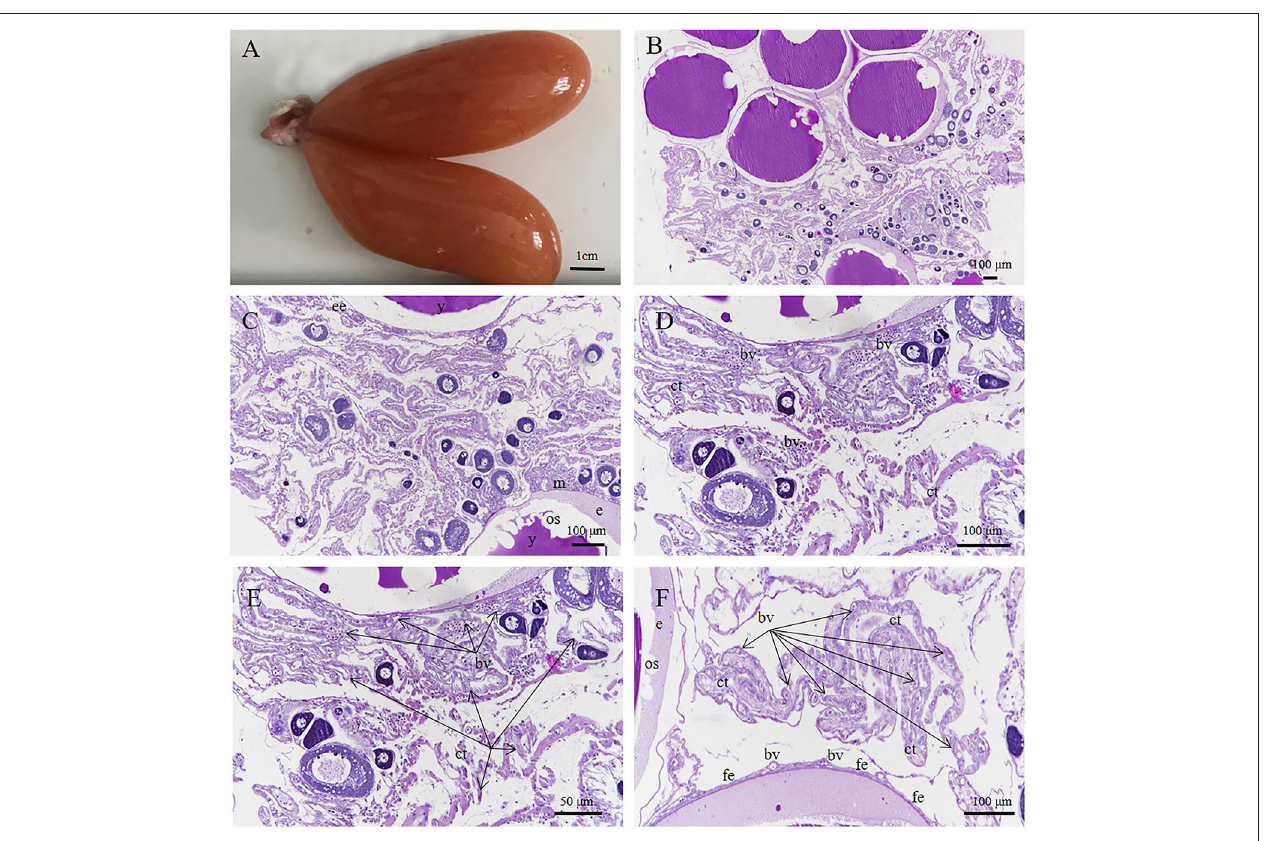
FIGURE 8 | S. schlegelii , embryos in the cleavage stage. (A) Morphology of ovary. (B) Embryos at cleavage. (C) The embryo (e) lives in the egg membrane (m), which contains yolk (y) and oil spheres (os). (D) Connective tissue (ct) and blood vessels (bv) surrounded immature or unfertilized eggs . (E) Connective tissue(ct) and blood vessels (bv) (F) A layer of follicular epithelium (fe) with many blood vessels (bv) around the embryo. Scale bars, 1cm (A) ; 100 µ m (B–D,F) ; 50 µ m (E) . HandE stained.